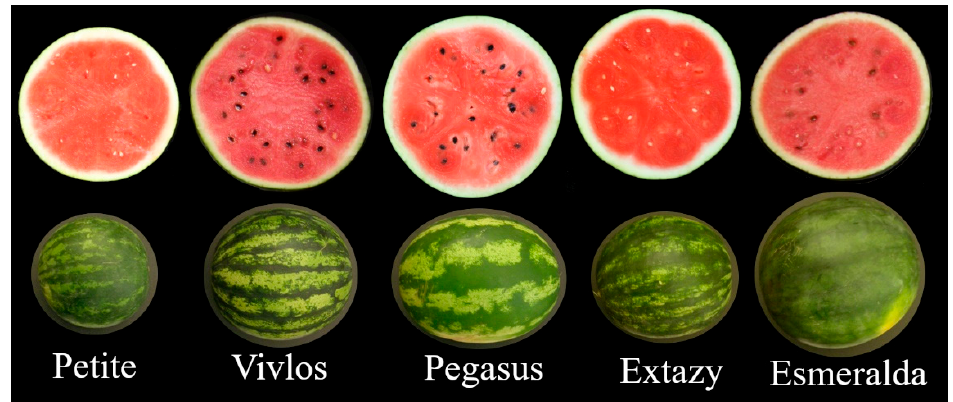
Figure 1. Intact and cross-sectioned watermelon fruit of cvs. Petite, Vivlos, Pegasus, Extazy and Esmeralda.